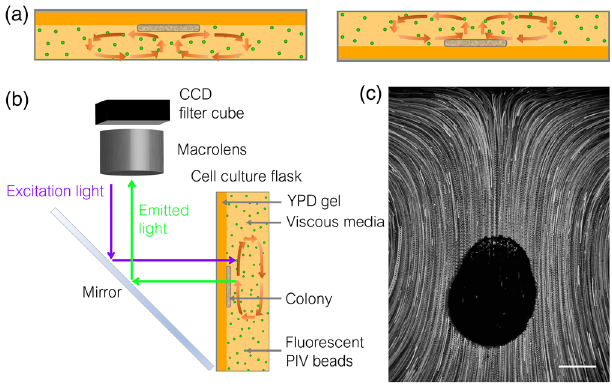
FIG. 4. Experimental setup for a yeast colony growing on a thin layer of agar in a sealed container filled with the viscous liquid; no liquid-air interfaces are present, removing the possibility of Marangoni flows. (a) The colony is anchored to the top or bottom walls of a Petri dish and (b) on the side wall of a culture flask. Gravity points downward, and the fluid is seeded with fluorescent PIV beads to track fluid motion. (c) Fluid flow streamlines near the yeast colony (the dark circular patch) in the same configuration as (b) during a time interval of Δ t ≈ 6 h obtained via maximum intensity projection. The scale bar corresponds to 5